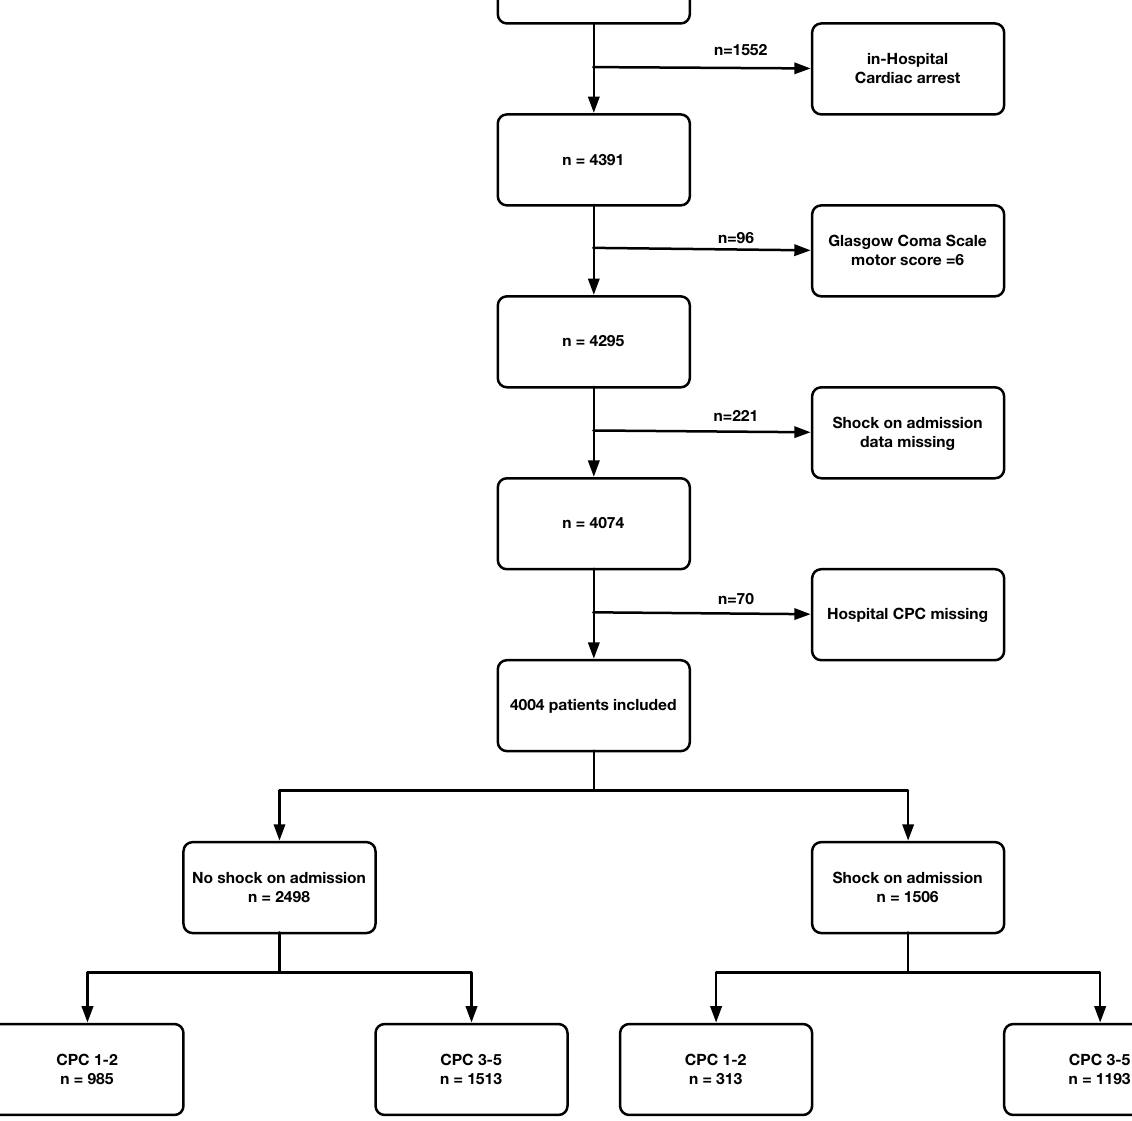
Figure 1. CONSORT flowchart. 4004 patients were included in the final analysis. CPC Cerebral Performance